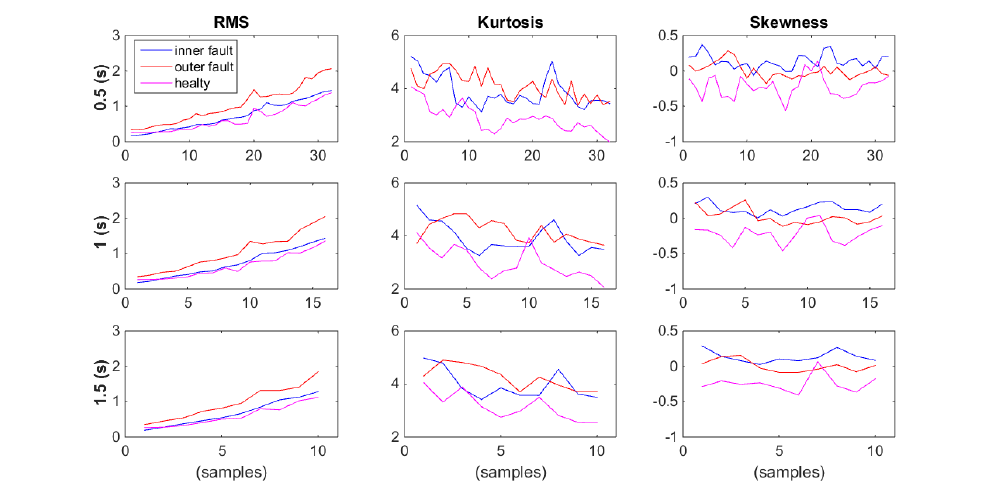
Figure 7. Variations of feature values for different duration of data input for linear speed tests. RMS: root mean